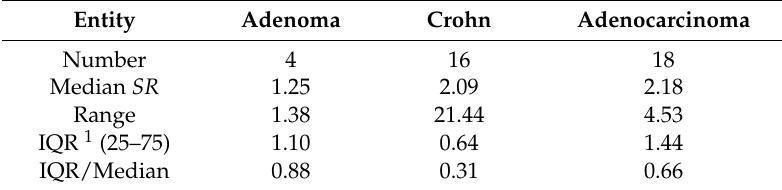
Figure 3. Elastogram of a newly resected bowel lesion from the colon containing a malignant tumor (adenocarcinoma). The hypoechoic tumor mass ( right ) is imaged with a blue-green color indicating harder tissue ( left ). The SR measured between pericolic fat and connective tissue, as well as part of the proper muscle and the tumor tissue, was 1.56. The lesion and reference are positioned at similar depth and distance from the stress source and the bottom. Table 2. Elastography strain ratio (SR) in resected surgical bowel specimens.